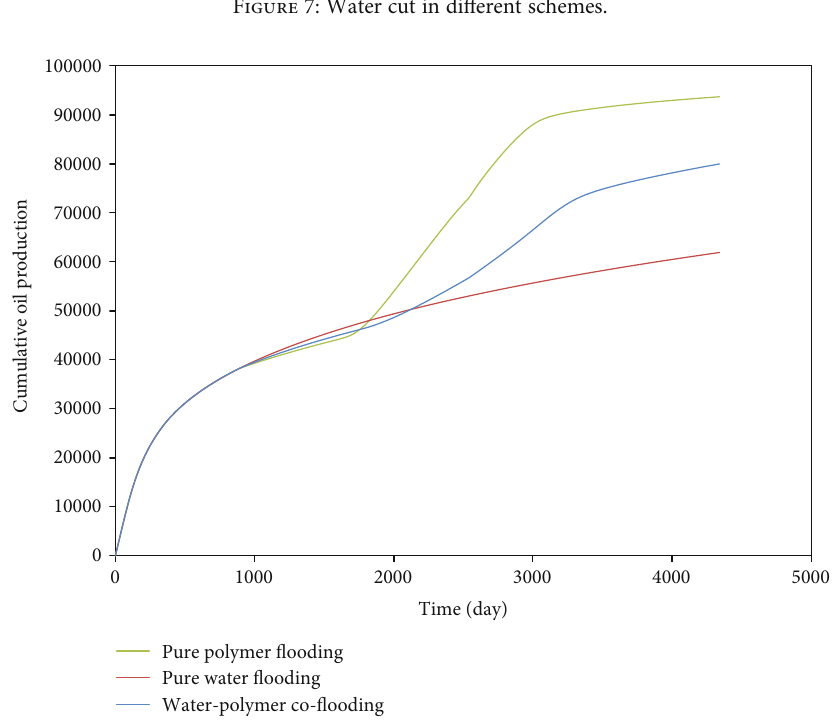
Figure 8: Cumulative oil production in di ff erent